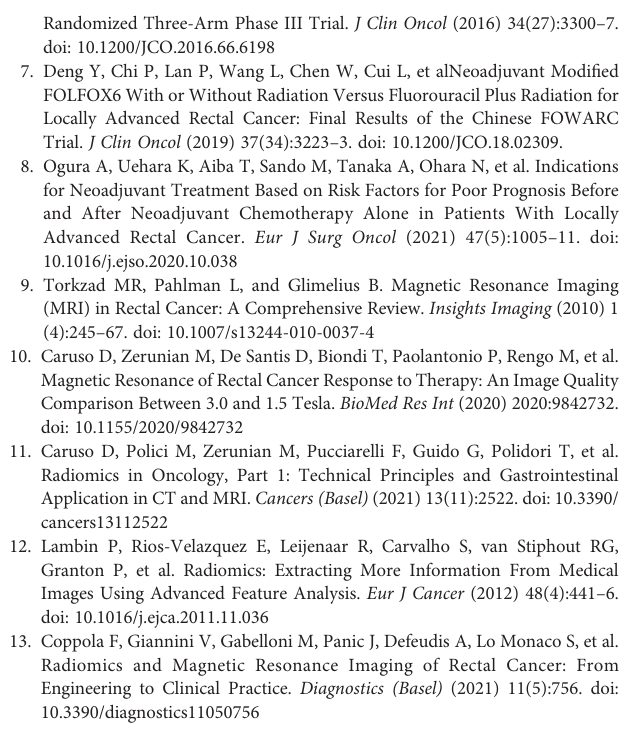
Supplementary Figure 1 | Texture feature selection using the least absolute shrinkage and selection operator binary logistic regression model. (A, B) Selection of peritumor radiomics. (C, D) Selection of intratumor